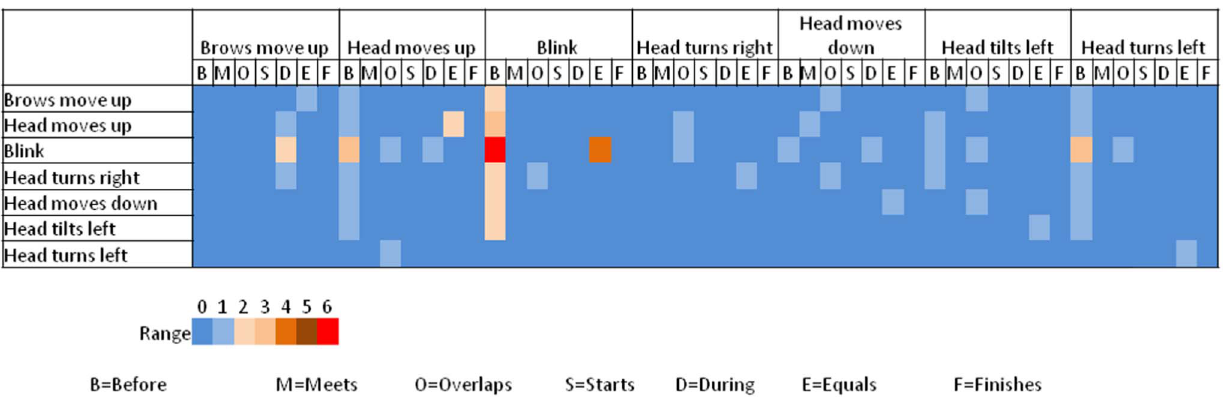
Figure 6. Visual representation of the ATL feature vector x . The dark blue color indicates a low number of occurrences for an event, while a dark orange color indicates a high number of repetitions. This figure is the histogram corresponding to the example in Fig. 5. The feature vector entries ( x k ) are read from left to right ( k ~ 1, ... ,49 ).